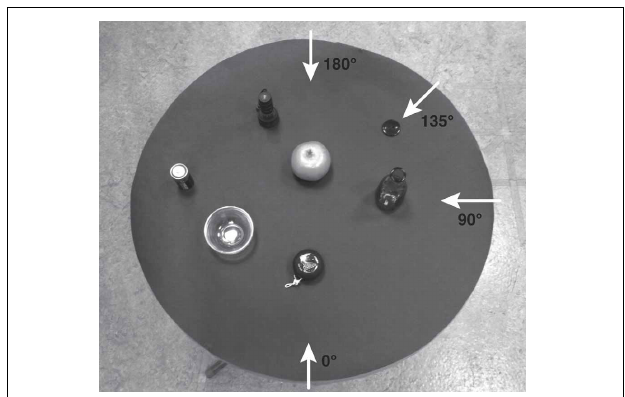
FIGURE 1 | One of the three seven-object layouts used in Galati et al. (2013),whose configuration was designed to appear seemingly random. It comprised a battery, a flashlight, a bowl, an orange, a yoyo, a button, and a vase. The arrows represent the Director’s viewpoint (0 ◦ ), and the Matcher’s viewpoint when offset by 90 ◦ , 135 ◦ , and 180 ◦ .